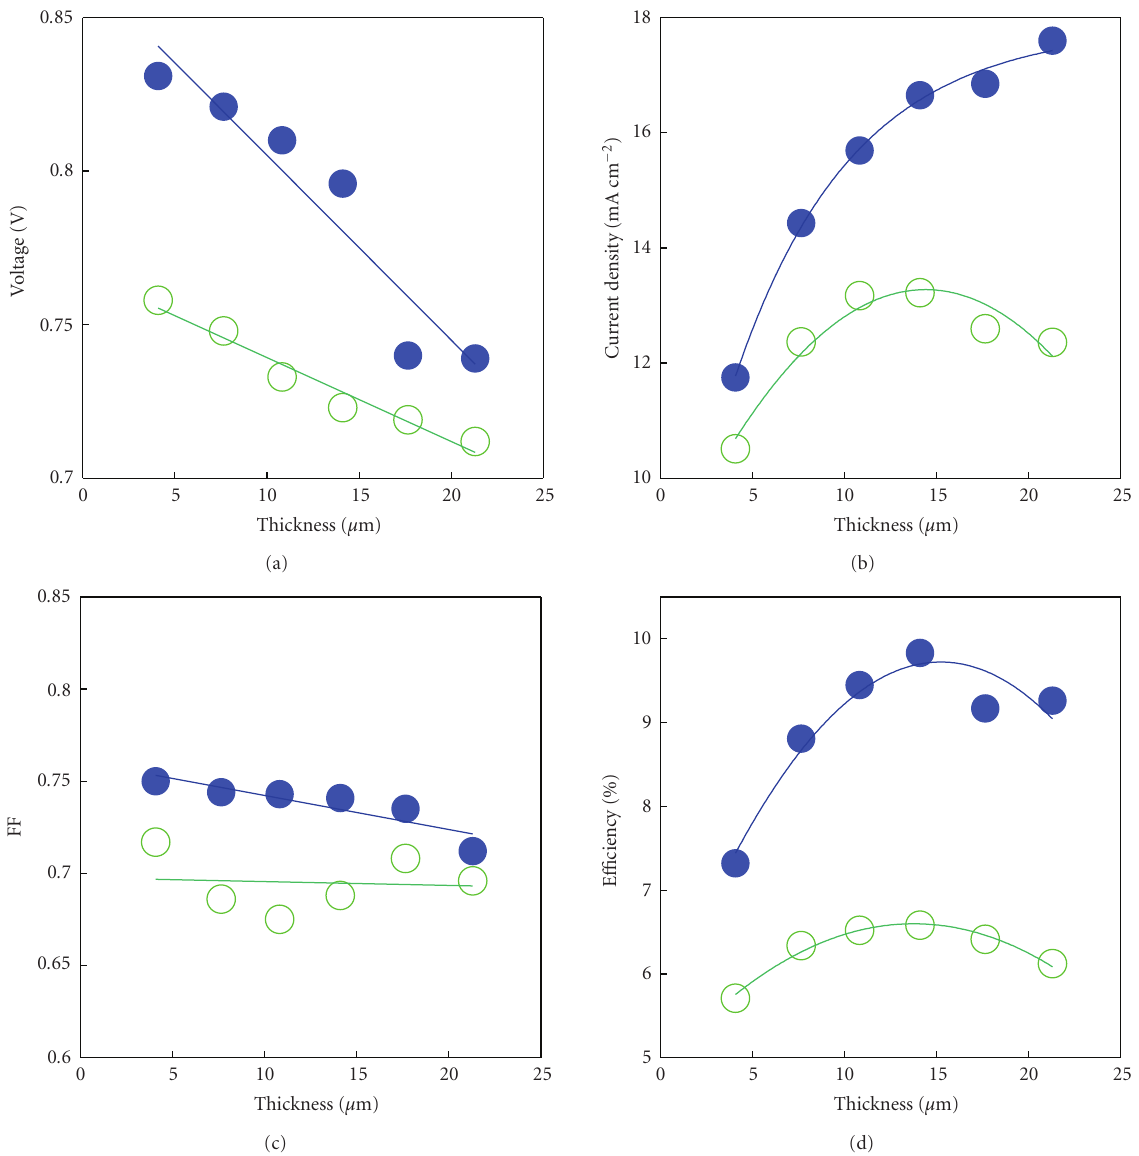
Figure 6: Photovoltaic characteristics related to the thickness of nanocrystalline-TiO 2 ( d = 42nm) layers of single-layer electrodes (as shown in Figure 1(a)): N719-sensitized solar cells using AcCN-based electrolytes (solid circles); Z907-sensitized solar cells using IL electrolytes (open